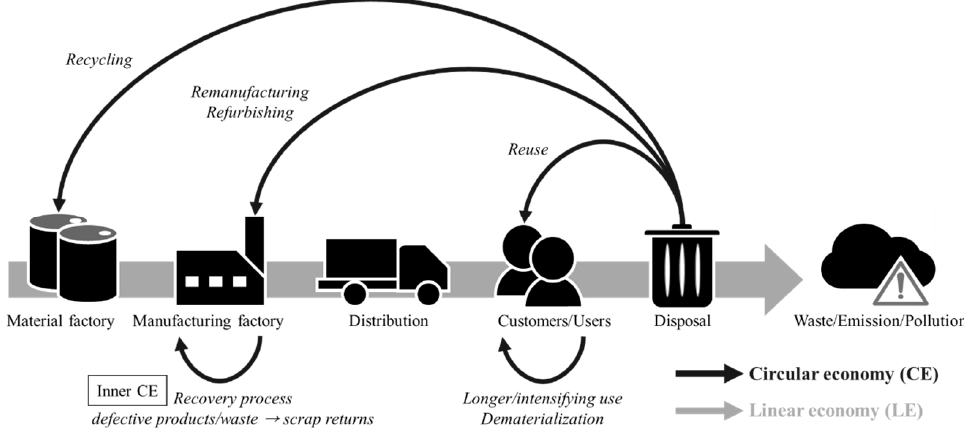
Figure 1. A brief introduction to CE and LE.